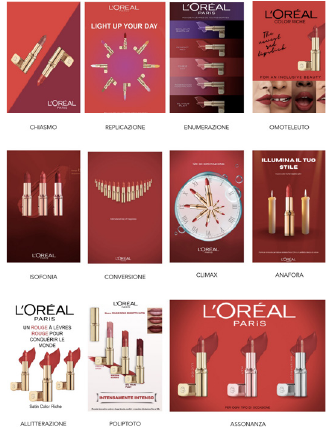
Figs. 1a- 1c Repetition figures. The group brings together rhetorical figures working through the repetition of visual